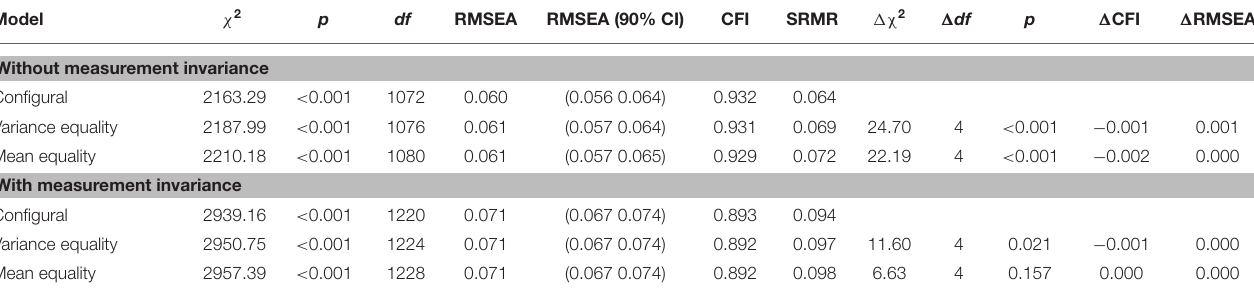
TABLE 9 | Cross-national LCM for accuracy model within the mother–child